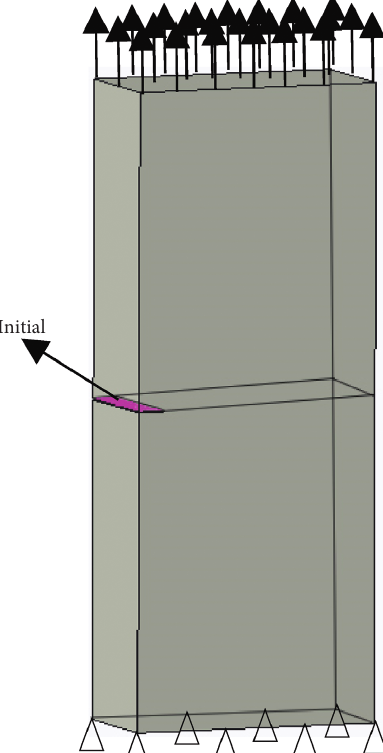
Figure 7: Plate structure with a unilateral